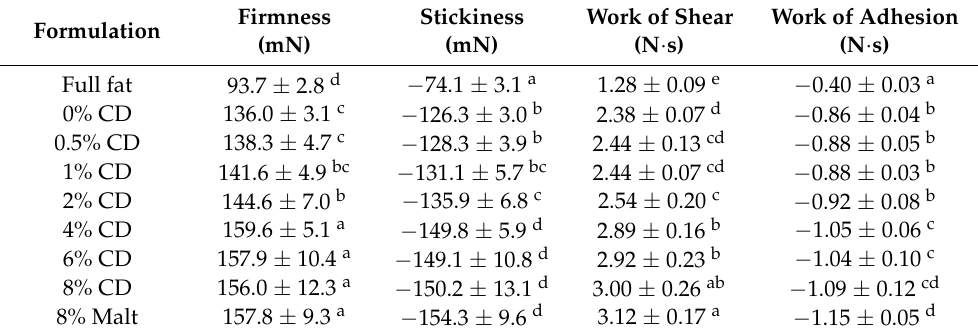
Table 3. Firmness, stickiness, work of shear, and work of adhesion (CD = corn dextrin, Malt = maltodextrin).